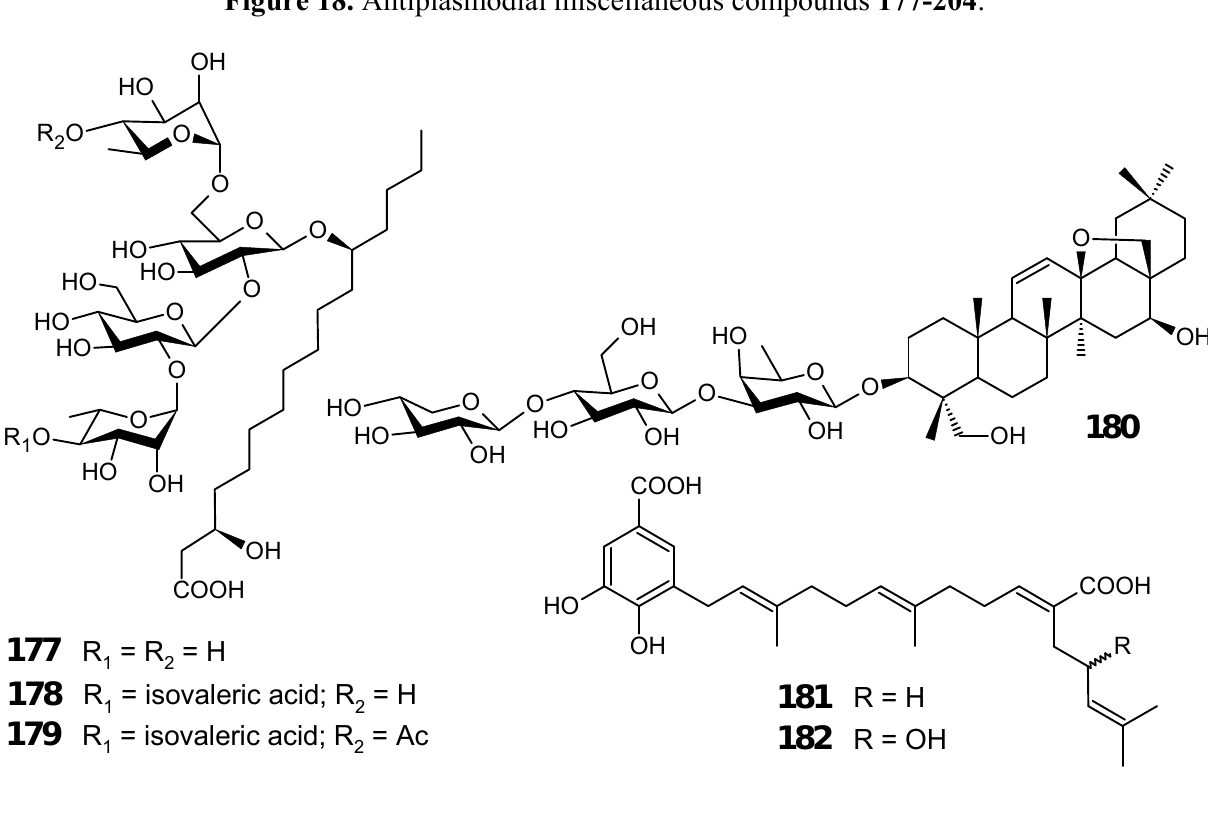
Figure 18. Antiplasmodial miscellaneous compounds 177-204